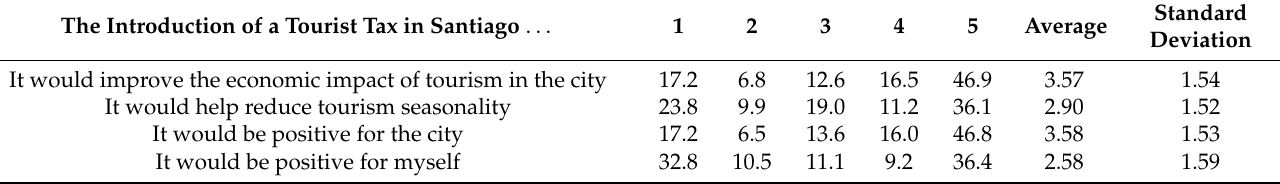
Table 2. Results for 4 statements regarding the perception of the implementation of the tax.